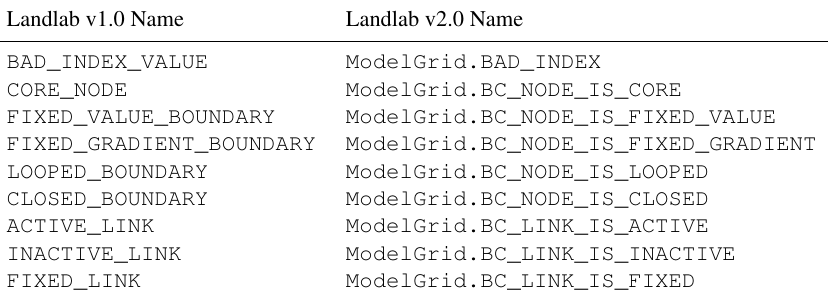
Table 6. Boundary condition flag